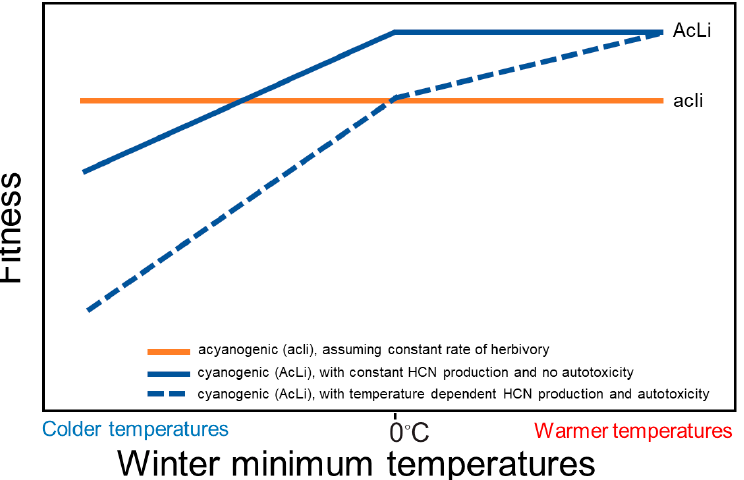
Figure 5. Conceptual model of how the costs and benefits of the hydrogen cyanide (HCN) chemical defense vary with winter minimum temperature in Trifolium repens . If there is a constant level of herbivory with variation in temperatures, acyanogenic plants (acli phenotype–orange line) are not expected to show large differences in fitness with variation in temperature. For cyanogenic plants (AcLi phenotype), if HCN expression is not dependent on temperature and if there is no autotoxicity at freezing temperatures (solid blue line), cyanogenic plants are expected to experience higher fit- ness relative to acyanogenic plants at winter minimum temperatures > 0 °C because of the protection the defense provides against herbivores. AcLi plants are expected to exhibit lower fitness than acy- anogenic plants in climates with freezing temperatures because freezing temperatures exacerbate allocation costs of producing cyanogenic glycosides and linamarase [20]. When HCN expression is dependent on temperature and there is freezing-induced autotoxicity (dashed blue line), allocation costs and physiological costs of autotoxicity are compounded at freezing temperatures, and the ben- efit of the defense increases with temperature >15 °C. The effects of temperature on the benefits and costs of defense make the evolution of HCN more restrictive. If herbivory also increases with warm- ing temperatures, as predicted by the latitudinal herbivory-defense hypothesis [61], then the condi- tions for the evolution of HCN are relaxed because the relationship between fitness and tempera- tures would be negative for acli plants. We display winter minimum temperature on the x-axis be- cause it is freezing temperatures that are hypothesized to induce allocation and autotoxicity costs on plants. 5. Materials and Methods 5.1. Study System White clover ( Trifolium repens L., Fabaceae) is a short-lived perennial herbaceous plant, native to Europe and central Asia that is cultivated globally in temperate zones for forage and soil nutrification [62]. The cyanogenesis polymorphism of white clover results in four cyanotypes: cyanogenic plants with a minimum of one dominant allele at each locus (i.e., Ac– Li–) produce both precursors (i.e., cyanogenic glycosides and linamarase) and release HCN, whereas acyanogenic plants include three cyanotypes that produce cy- anogenic glycosides but no linamarase (Acli), linamarase but no cyanogenic glycosides (acLi), or neither component (acli). 5.1.1. Plant Materials To assess the costs and benefits of HCN defense, plants of all four cyanotypes (i.e., AcLi, Acli, acLi, acli) of T. repens were grown from F4 seed originating from an F0 paren- tal cross between an acaclili plant from Ontario, Canada, and an AcAcLiLi plant from Louisiana, USA. The original parental cross resulted in plants that were all cyanogenic and therefore heterozygous AcacLili. These heterozygotes were randomly crossed with one another to produce an F2 population segregating at Ac and Li. Random crosses in the F2 and F3 generations were performed among plants within the same cyanotype (i.e., AcLi, Acli, acLi, acli), which increased the frequency of homozygous genotypes at Ac and